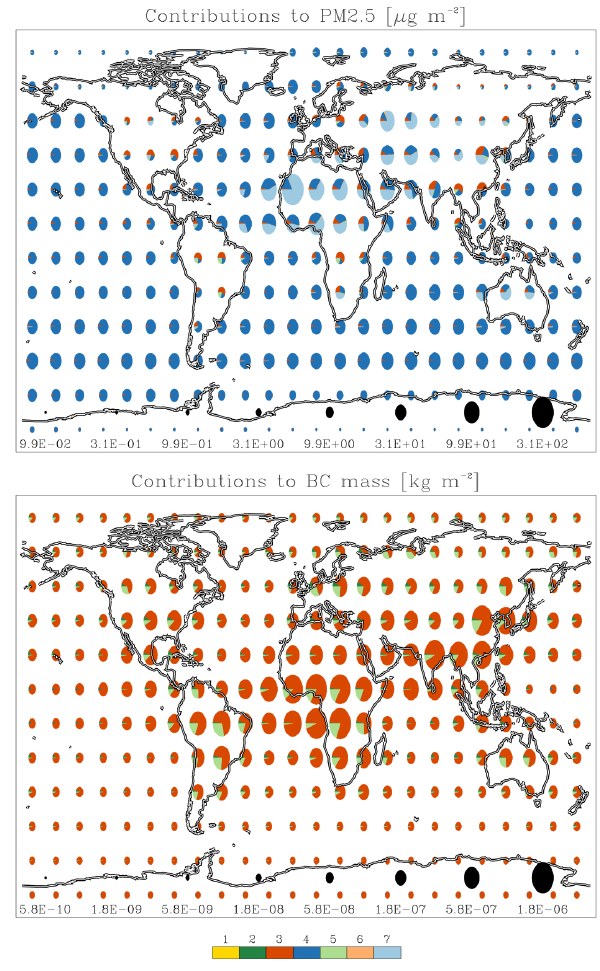
Figure 3. Contributions by different modes to surface PM 2 . 5 and black carbon mass burden for the baseline experiment. The pie chart colors show contribution by mode (see legend below lowest panel), the pie chart’s size shows the overall magnitude (legend at the bot- tom of each panel). From top to bottom: surface PM 2 . 5 (logarithmic scale); black carbon mass burden (logarithmic